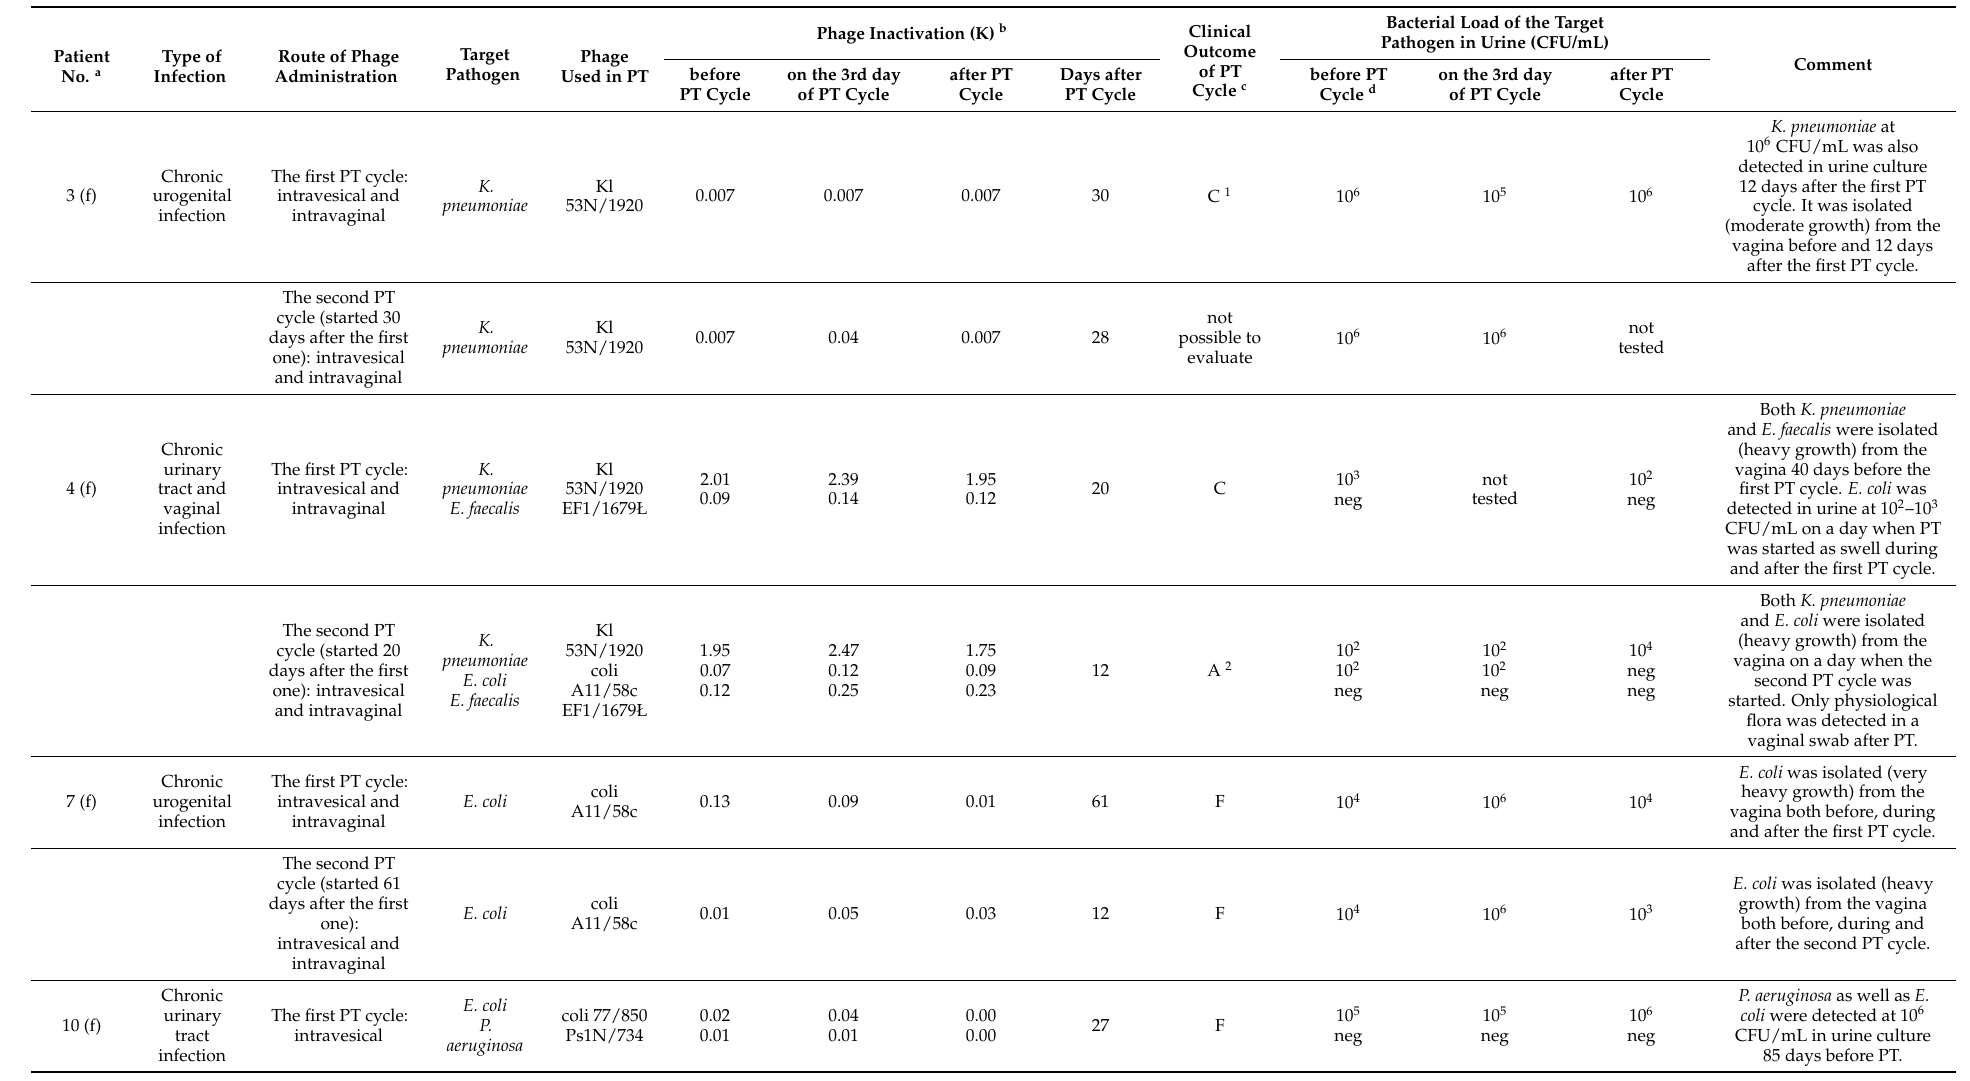
Table 2. Patients with chronic urinary or urogenital infections undergoing two cycles of phage